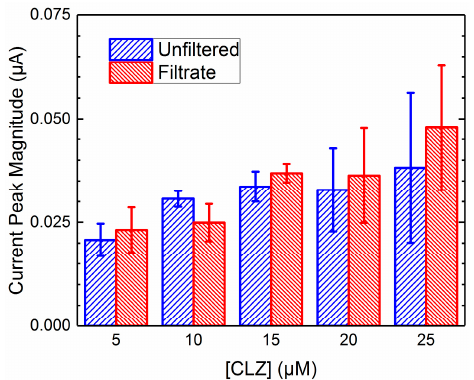
Figure 5. Current peak magnitudes of unfiltered solutions and filtrates of BSA and CLZ mixtures across varying concentrations of CLZ. Values displayed as mean ± standard deviation; p = 0.73 between unfiltered vs. filtrate groups, n = 3.